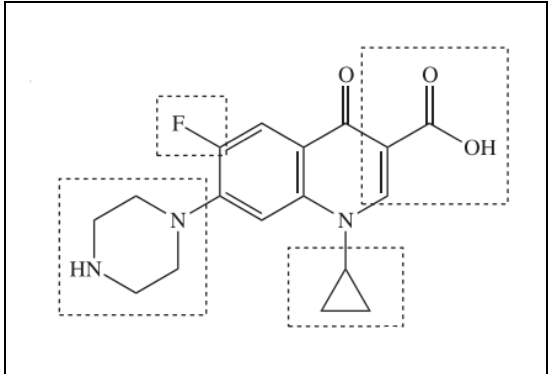
Figure 5. Different attack sites in CIP structure by free radicals generated by photocatalytic reaction.